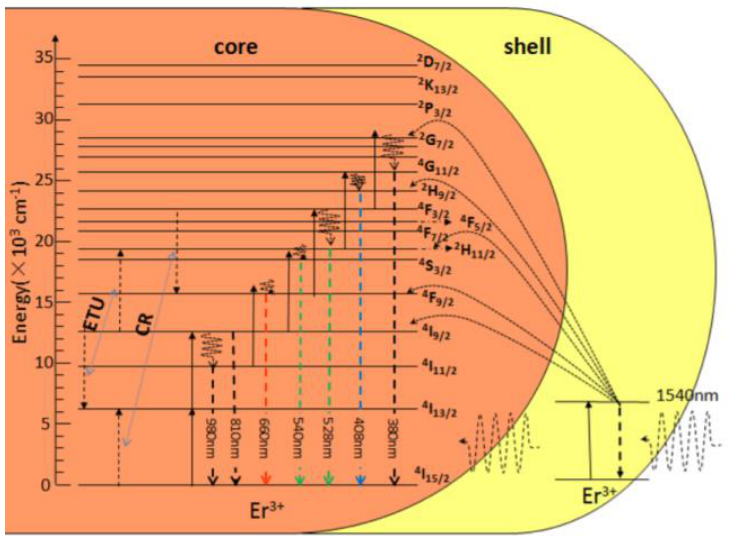
Figure 25. Energy transfers and de-excitations involved in NaGdF 4 :12%Er 3+ @NaGdF 4 :10%Er 3+ active-core/active-shell NPs under 1540 nm excitation. Reproduced from [232], with permission from Beilstein-Institut Publisher, 2017.